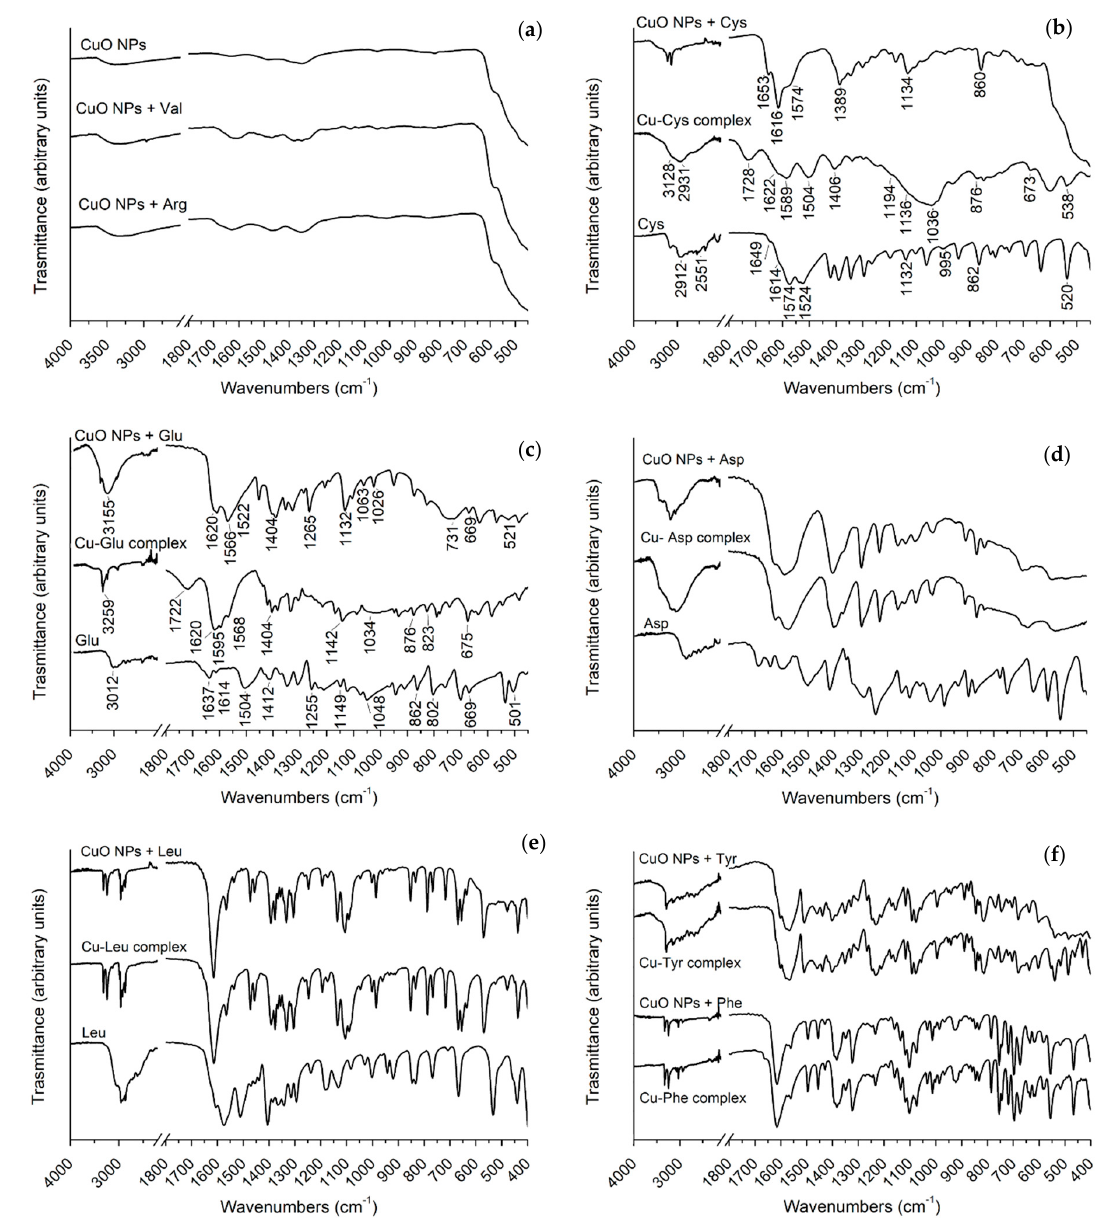
Figure 2. Fourier Transform Infrared spectroscopy (FTIR) spectra of ( a ) CuO nanoparticles (CuO NPs) pristine and treated with Arg and Val; ( b ) free Cys, Cu-Cys complex and CuO NPs treated with Cys; ( c ) free Glu, Cu-Glu complex and CuO NPs treated with Glu ( d ) free Asp, Cu-Asp complex and CuO NPs treated with Asp; ( e ) free Leu, Cu-Leu complex and CuO NPs treated with Leu; ( f ) Cu-Phe complex, CuO NPs treated with Phe, Cu-Tyr complex and CuO NPs treated with